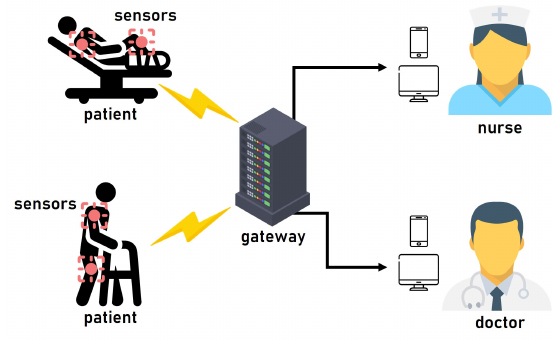
Figure 1. The general system model of